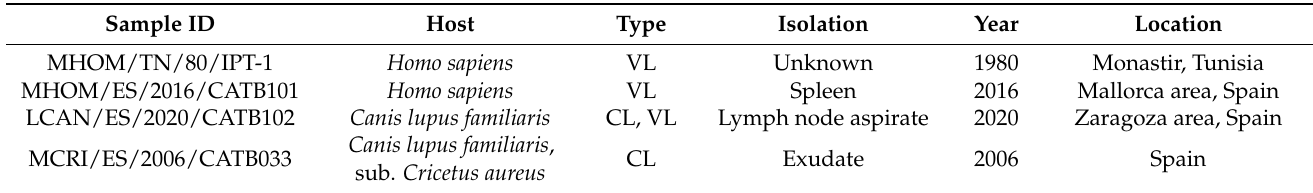
Four cultured L.